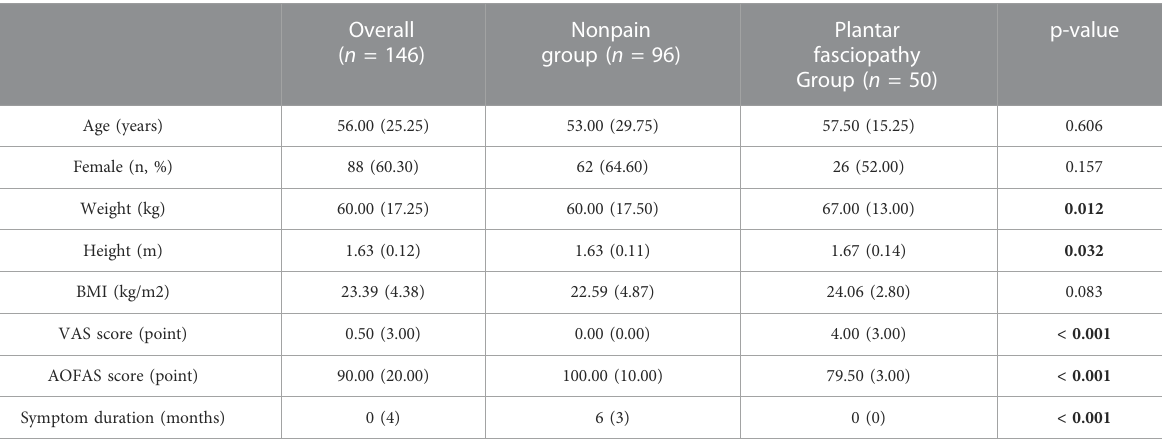
TABLE 2 Baseline characteristics of the subjects.